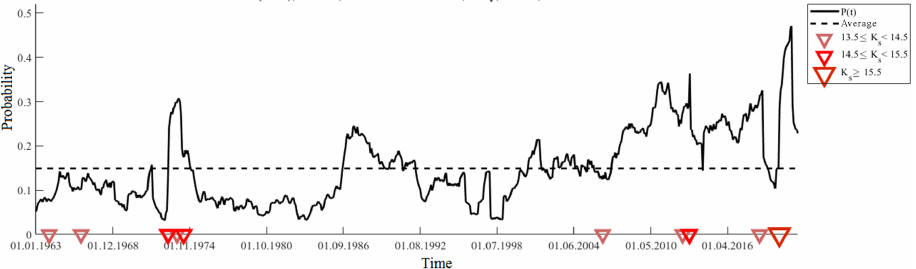
Figure 2. Time series of probability values P k ( S 2 ). Red triangles on the time axis indicate earthquakes with K S ≥ 13 . 5 ( M ≥ 6 .